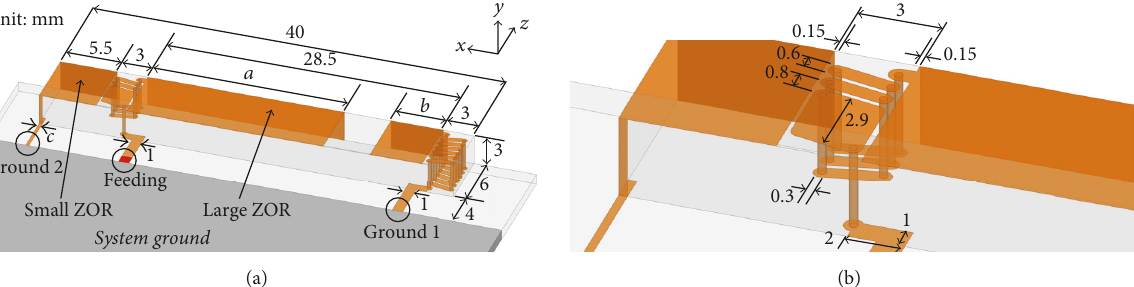
Figure 2: (a) Geometry of the proposed compact broadband dual ZOR antenna. (b) Detailed dimensions of the helix feed line ( 𝑎 = 19mm, 𝑏 = 5 mm, and 𝑐 = 0.3